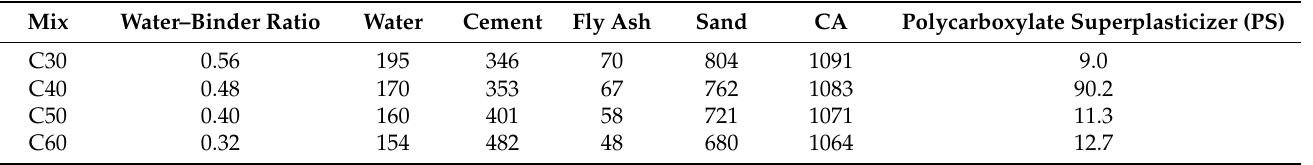
Table 2. Concrete mixing ratios (kg/m 3 ).